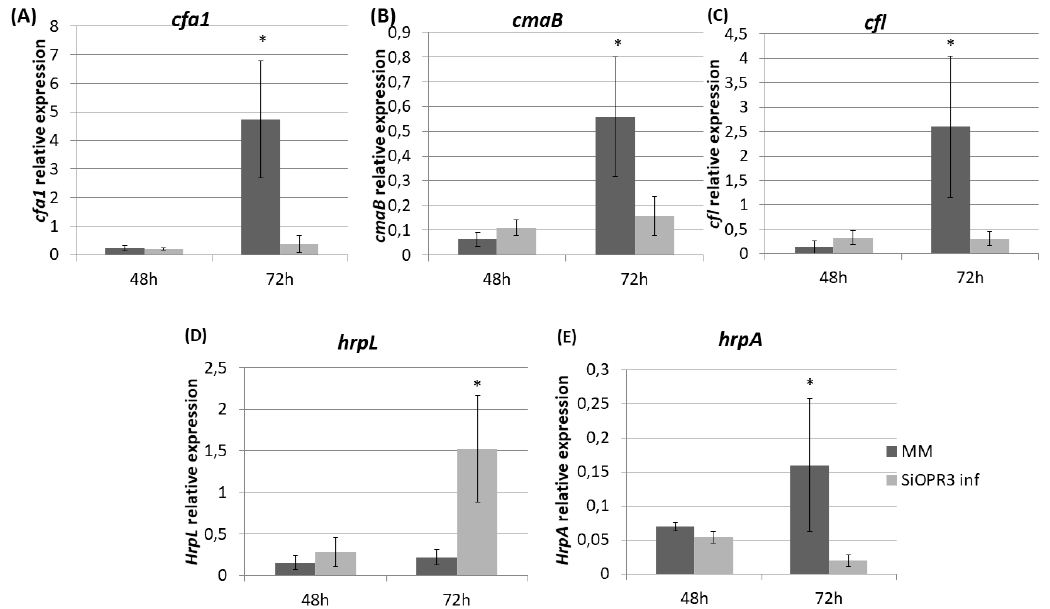
Figure 4. Expression of coronatine (COR) synthesis genes and of type III secretion system-related genes from Pst extracted from infected leaves of MM and SiOPR3 plants. The transcript levels of cfa1 ( A ), cmaB ( B ), cfl ( C ), hrpL ( D ), and hrpA ( E ) were examined at 48 and 72 h postinoculation, using qRTPCR with specific primers. The recA gene was used as an endogenous reference gene. The results represent the means and standard error from three different experiments.